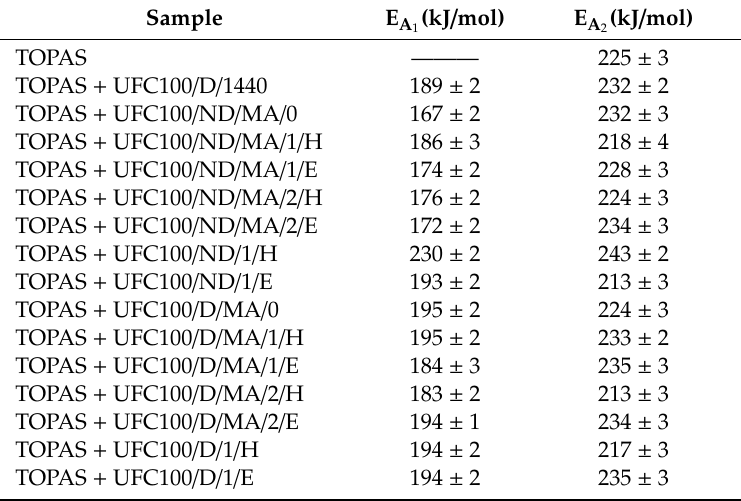
Table 4. Tabularized values of apparent activation energy assigned to the decomposition steps calculated with the use of Broido’s method [39]; E A —apparent activation energy of polymer matrix E A 2